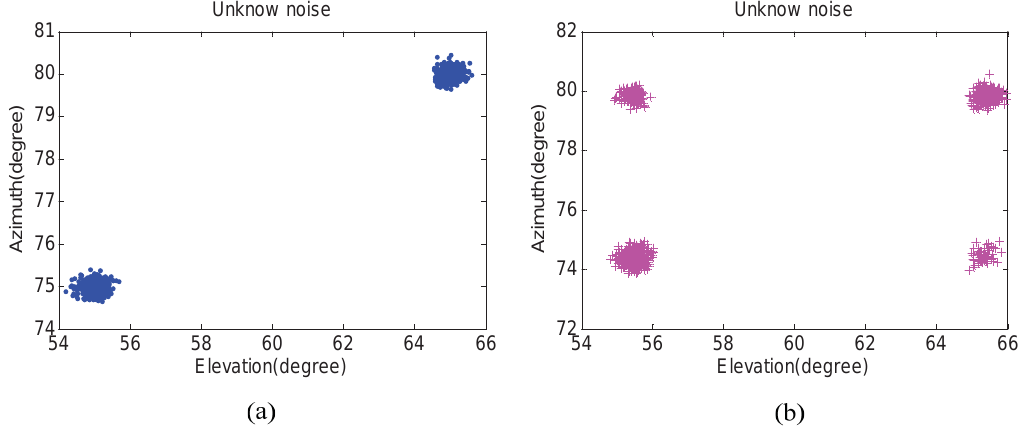
Figure 4. The angle estimation scattergram in an unknown noise situation. ( a ) The proposed algorithm; and ( b ) the Kikuchi